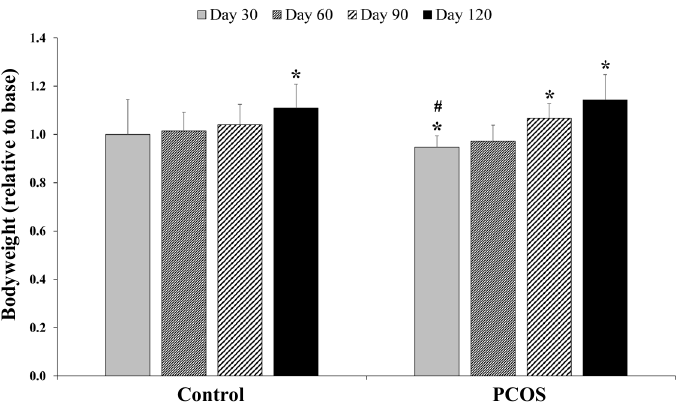
Figure 1 . Changes in the bodyweight of the Control and polycystic ovary syndrome (PCOS) groups. Means ± S.D.; * p < 0.05 vs. Base, # p < 0.05 vs. Control.